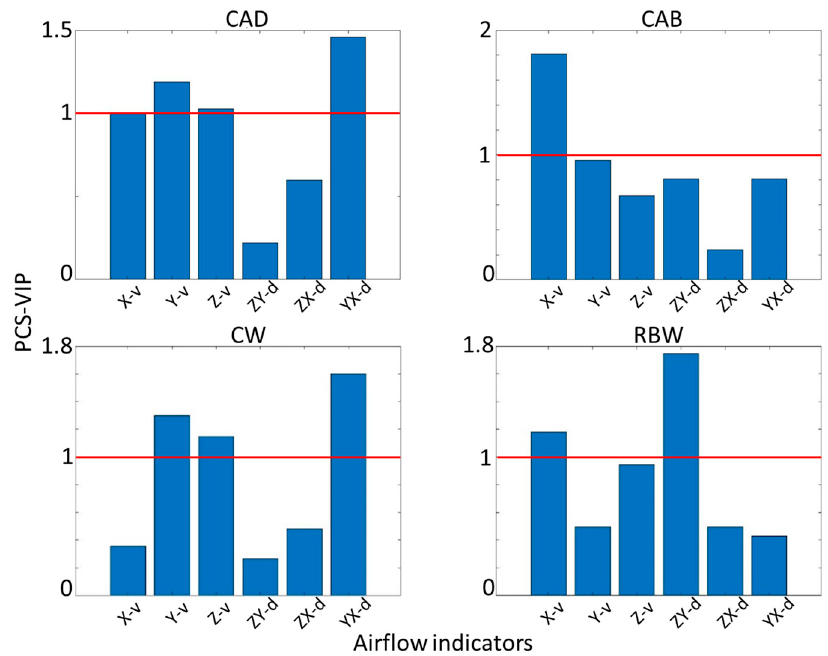
Figure 7. PLS-VIP analysis results between the airflow indicators and the deposit indicators of OSC1–OSC6. The red line marks the position where the PLS-VIP value is 1 As represented in Table 6, X-v had a relatively complex effect on canopy deposit cov- erage, showing positive correlations with CAB ( p < 0.05) and RBW ( p < 0.001) on the out- side of the cherry canopy, but negative correlations with CAB and RBW ( p < 0.05) on the inside of the canopy and CAD ( p < 0.01) on the outside of the canopy. Y-v showed a nega- tive correlation with CAD ( p < 0.01) and CW ( p < 0.05) inside the canopy, meanwhile YX- d showed the same negative correlation with CAD and CW of the total canopy ( p < 0.05), in addition, ZY-d showed a significant positive correlation with RBW inside the canopy ( p < 0.001). Although a few of the airflow indicators in Table 6 showed different contributions to those in Figure 7, this does not prevent the overall results from being consistent. Table 6. Results of the correlation analysis between airflow and deposit indicators at different parts of cherry canopy.